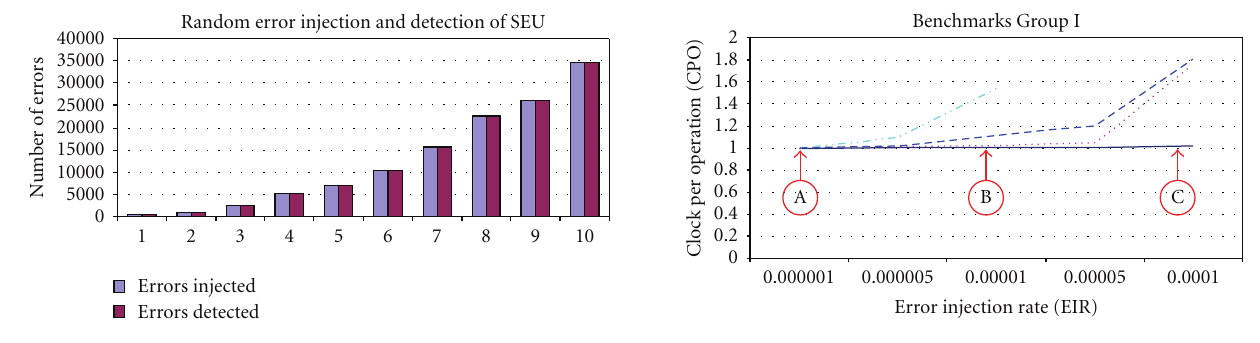
Figure 21: Results for single bit error injection.